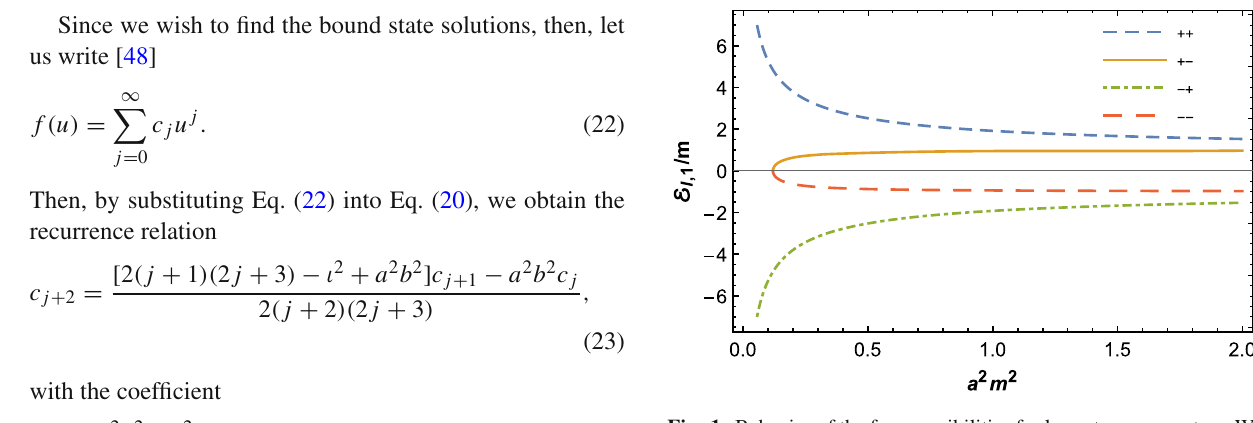
Fig. 1 Behavior of the four possibilities for lowest energy system. We choose l = 1 and α = 0 . 6. In the legend, the first sign refers to the sign outside the square root, while the second sign, inside the square root